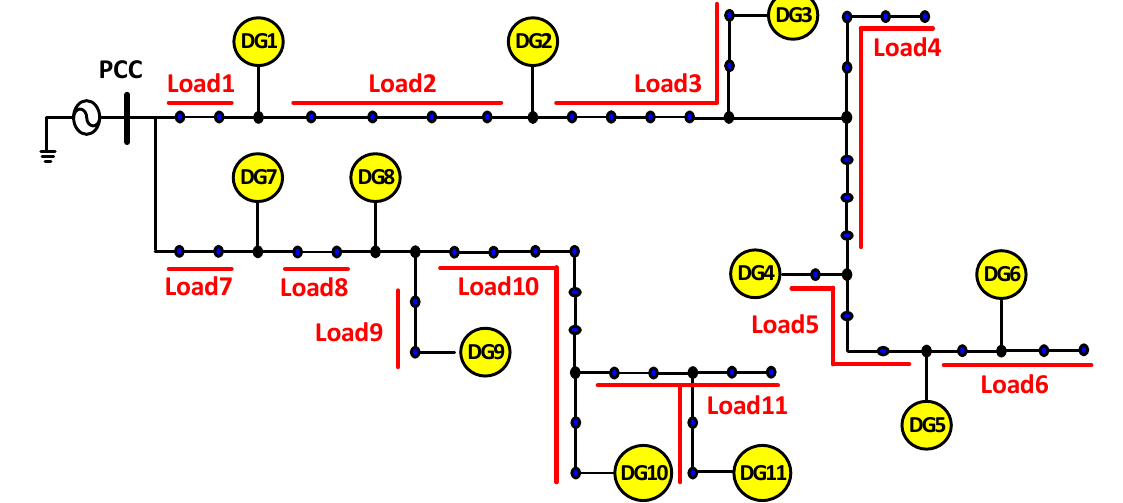
Figure 8. Virtual STATCOM Simulation Grid Diagram.